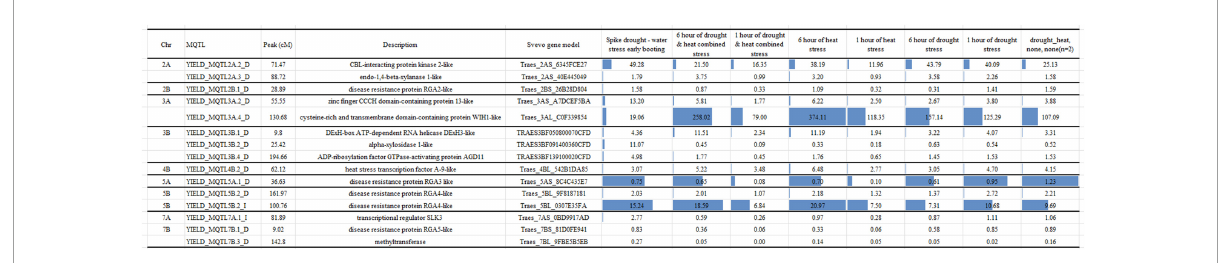
FIGURE5 Expressed genes identified in MQTL under irrigated and rainfed